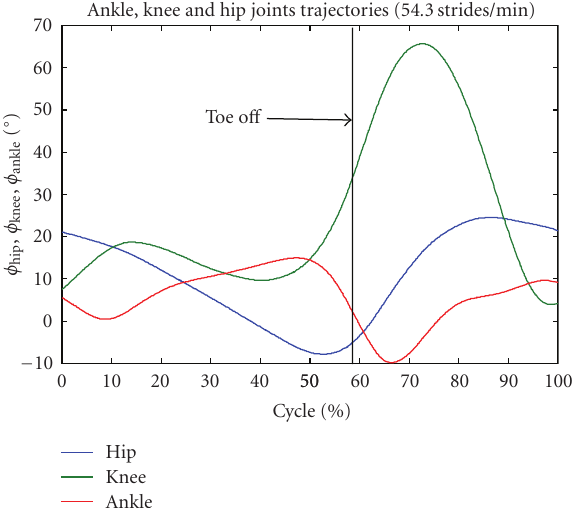
Figure 11: The hip, knee, and ankle joint angular accelerations.